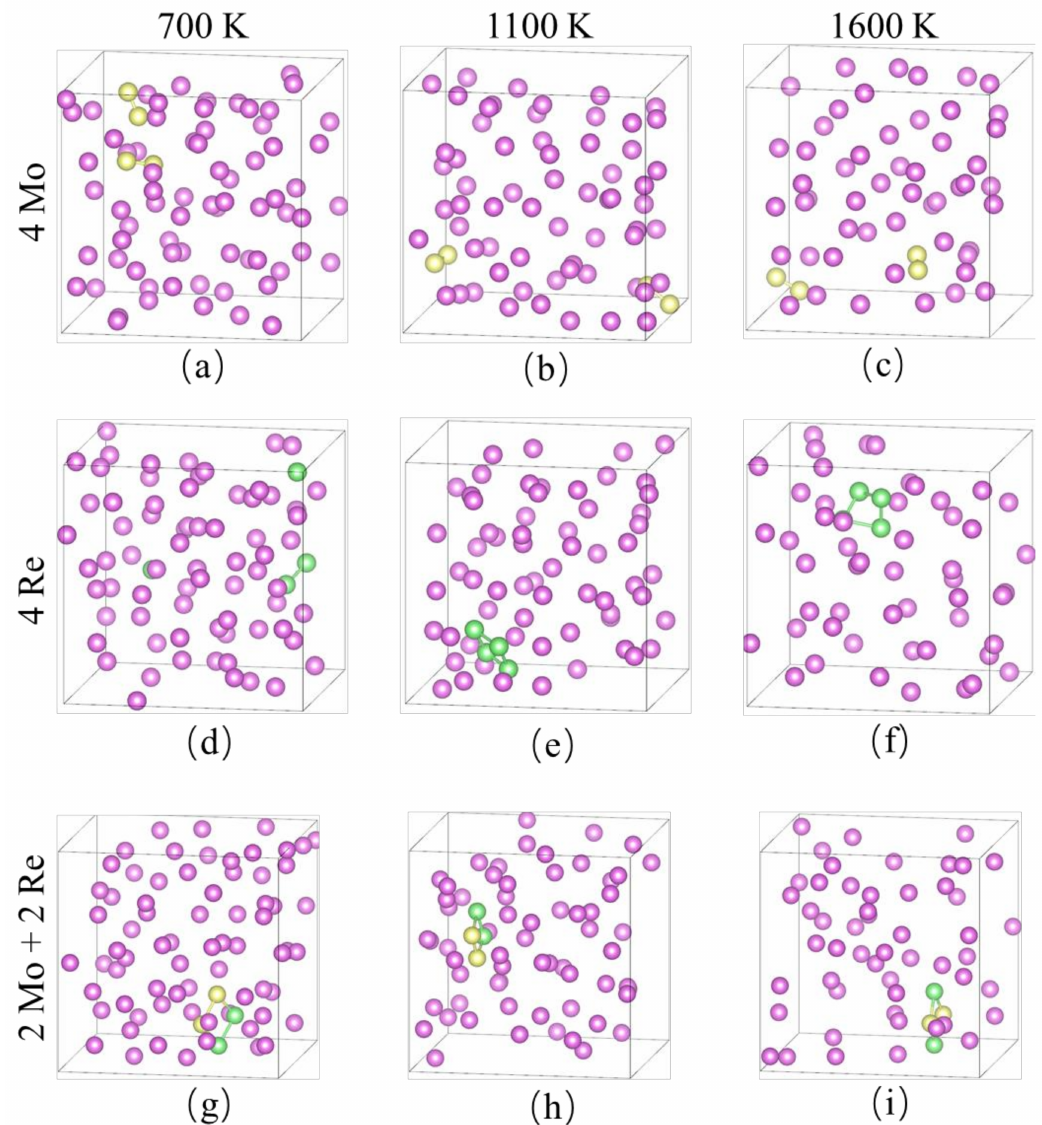
Figure 7. Structures of four solute atoms in liquid Na after 60 ps AIMD simulation: ( a – c ) four Mo atoms in liquid Na at 700 K, 1100 K and 1600 K; ( d – e ) four Re atoms in liquid Na at different temperatures; ( g – i ) two Mo atoms and two Re atoms in liquid Na at different